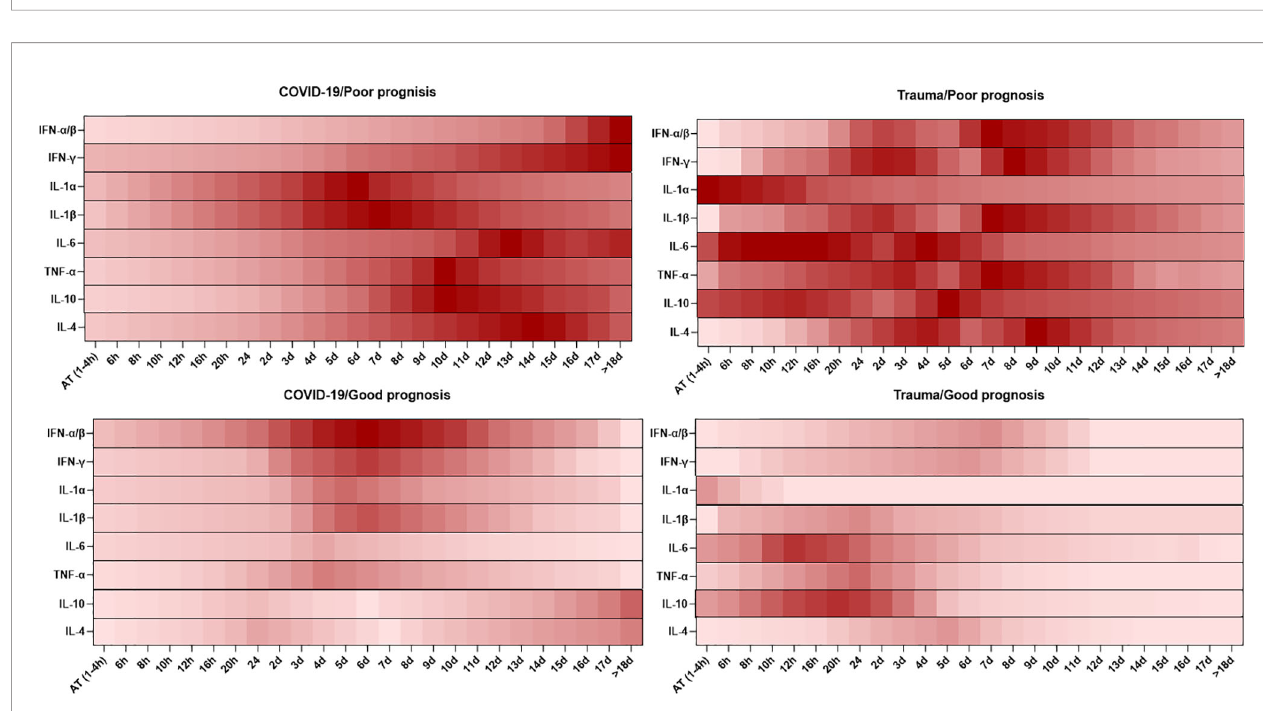
FIGURE 2 | Association between the kinetics of changes in serum levels of cytokines with prognosis in patients with COVID-19 and trauma. The heat map shows the kinetics of changes in serum IFN- a / b (82 – 86), IFN- g (86 – 89), IL-1 a (86, 90), IL-1 b (86, 90), IL-6 (30, 80, 91), TNF- a (26, 86, 92), IL-10 (26, 80, 91) and IL-4 (86, 92) levels during 18 days after admission in COVID-19 and trauma patients associated with poor and good prognoses. COVID-19 patients with an increased risk of mortality, MOF, severe-to-critical forms of the disease, intensive care unit admission, and/or hospitalization are de fi ned as a poor prognosis for the disease. Conversely, patients with the opposite are de fi ned as having a good prognosis for the COVID-19. AT, admission time; d, day; h, hour; IFN, interferon; IL, interleukin; MOF, multiple organ failure; TNF, tumor necrosis